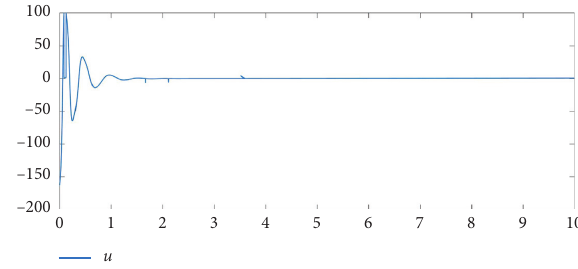
Figure 6: The response of the control law input u .